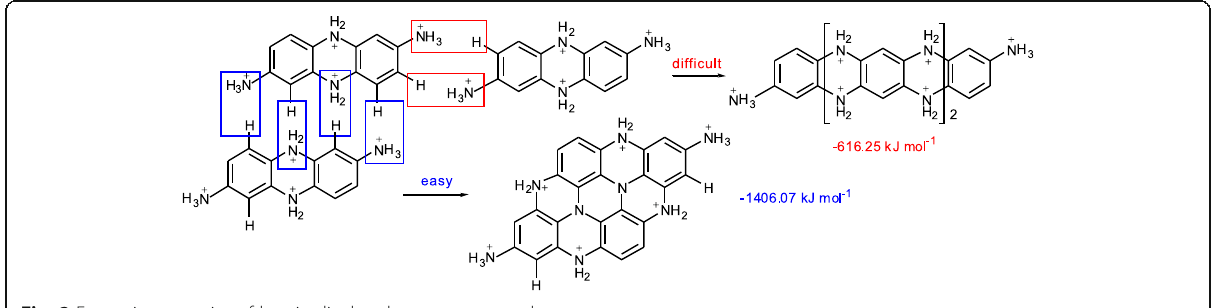
Fig. 2 Formation energies of longitudinal and transverse growths